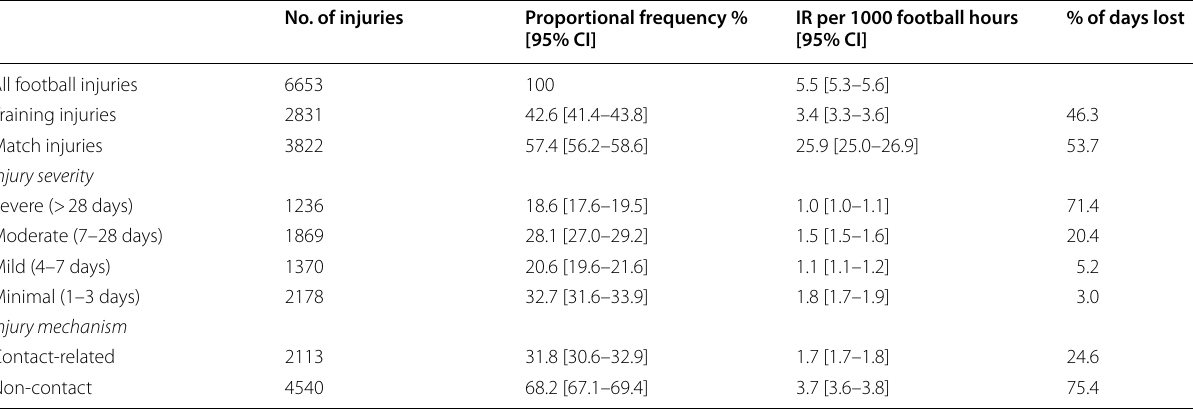
Table 1 Absolute numbers, proportions, IRs, proportions on overall time loss according to injury numbers, injury severity, and injury